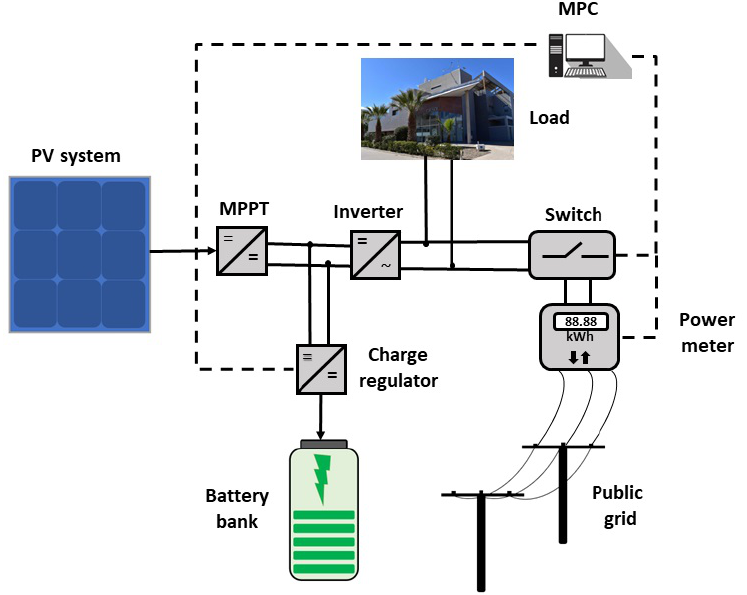
Figure 1. Simplified diagram of the MG.